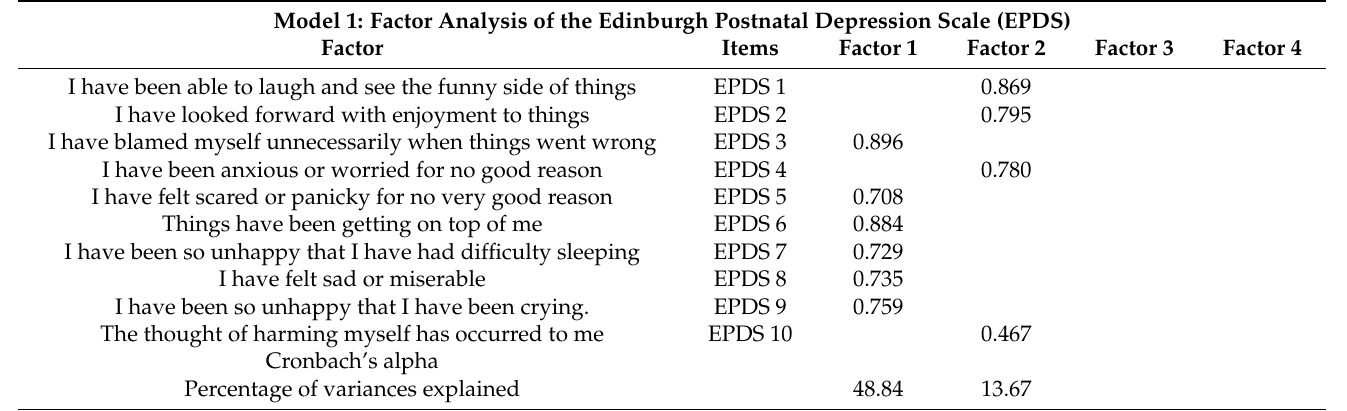
Table 2. Factor analyses using the promax rotation. Model 1: Factor Analysis of the Edinburgh Postnatal Depression Scale